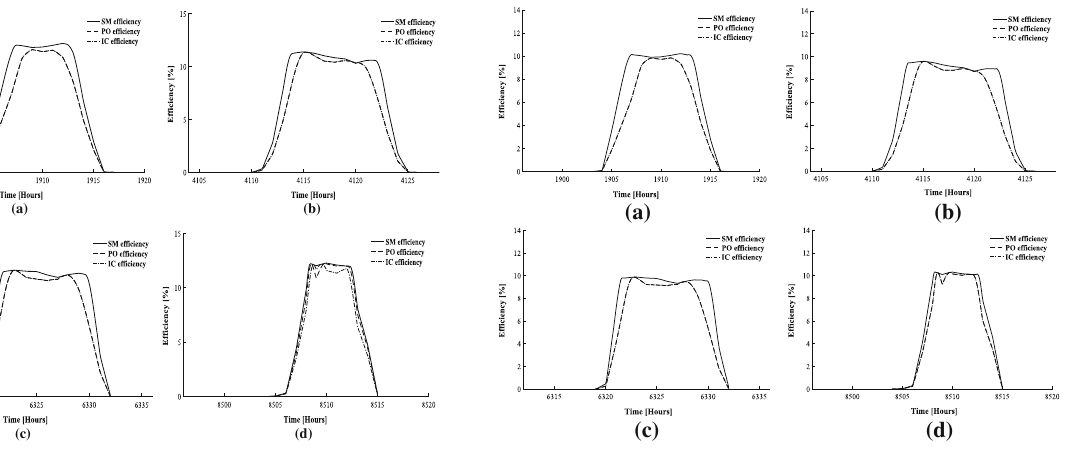
Fig. 8 Module Efficiencies using different MPPT techniques on the Mono-Si PV array SM55 for a March 21, b June 21, c